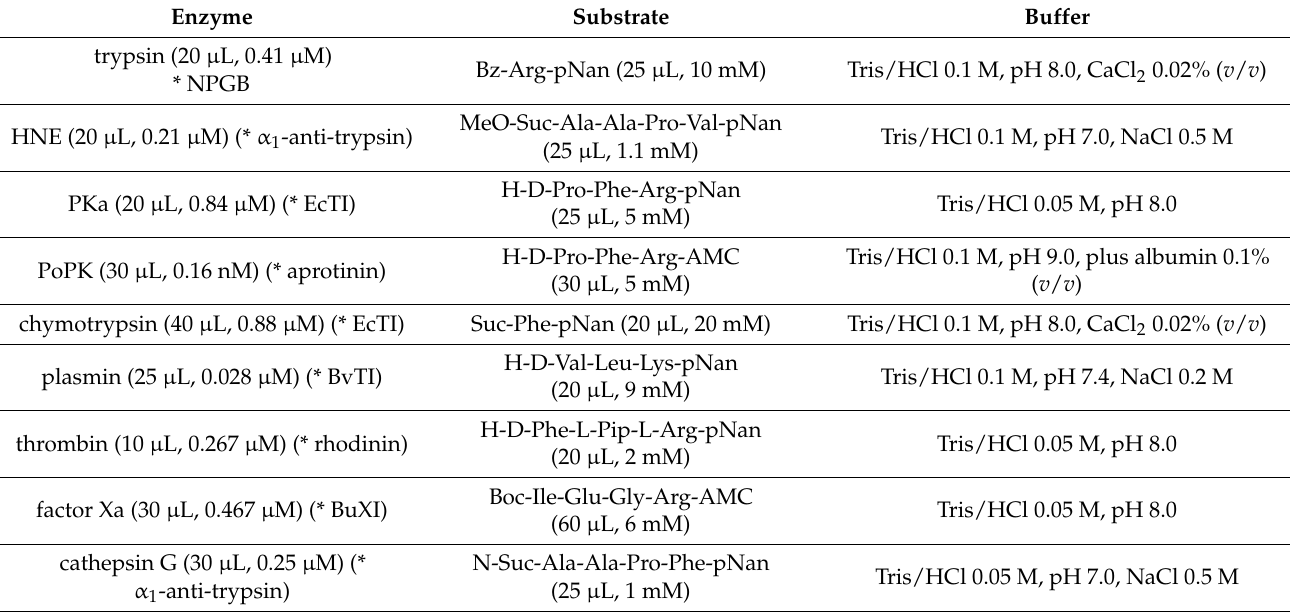
Table 2. Enzymes, substrates and buffer used to verify substrate hydrolysis by serino proteases and inhibitory activity. Enzyme Substrate